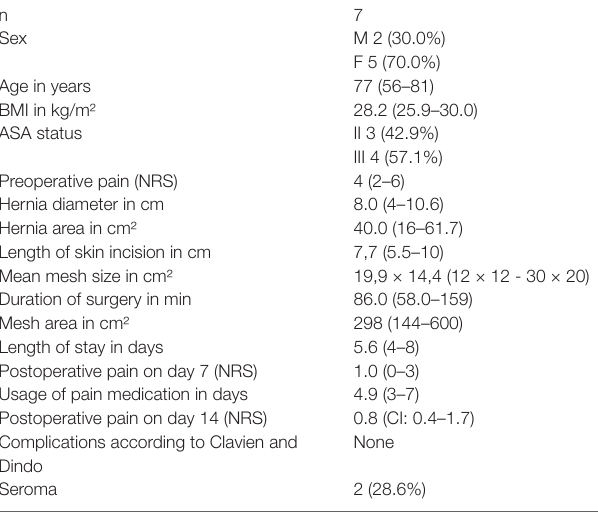
tAbLe 1 | Characteristics of study population.